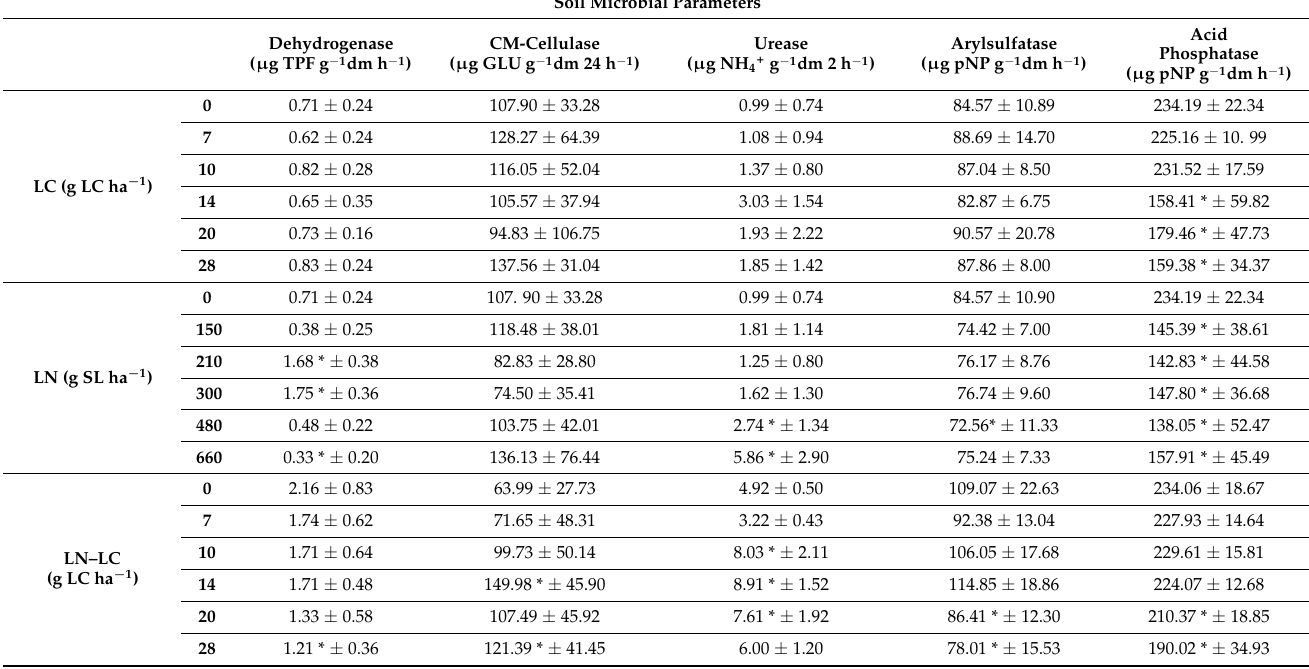
Table 3. Soil microbial parameters. Enzymatic activity of dehydrogenase, CM-cellulase, urease, arylsulfatase, and acid-phosphatase after exposure to different concentration of LC, LN, and LN–LC. The concentrations tested are based on the amount of LC. In the case of LN, the concentrations indicated are of solid lipid (SL) used in the synthesis of LN. Results are represented by mean ± SD values. The same concentrations of SL were tested for LN–LC. Asterisks mark the significant differences in relation to the control group (0 g LC ha − 1